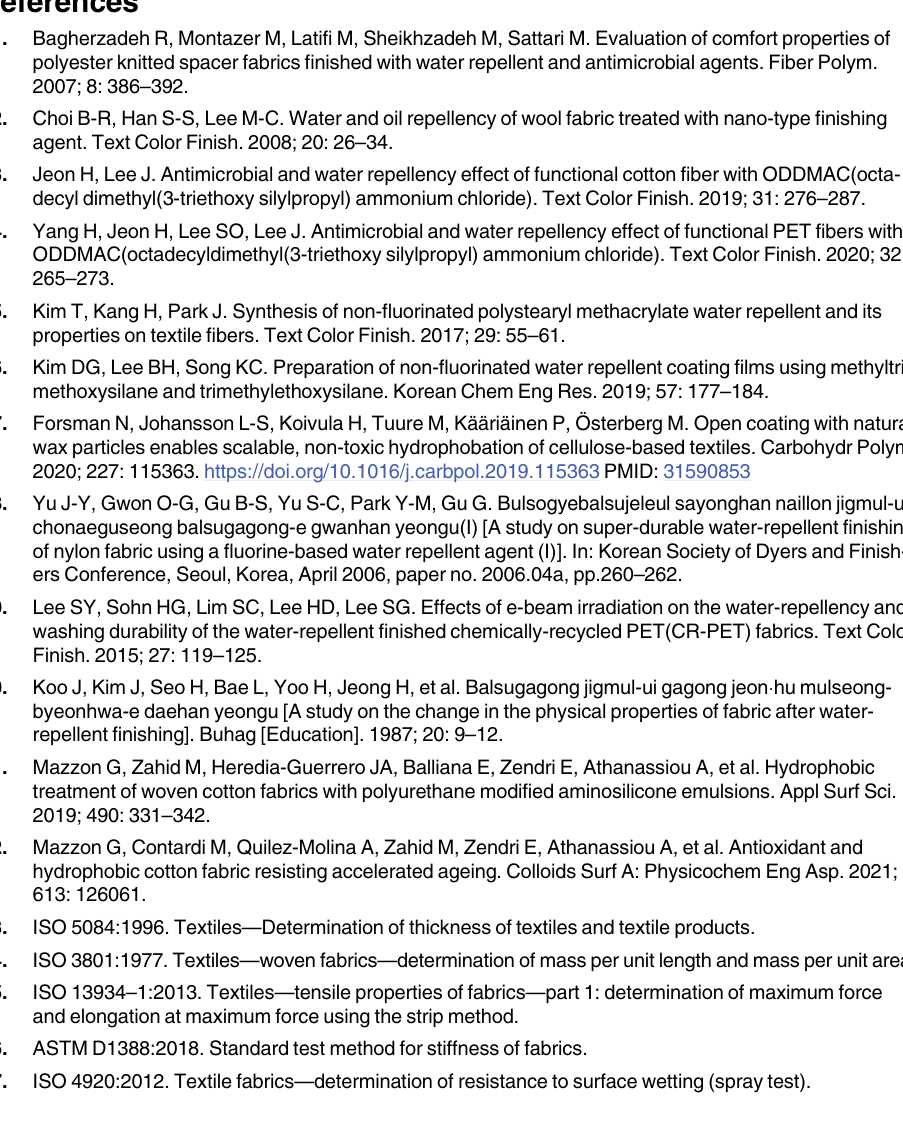
S1 Table. Physical properties of cotton woven fabrics measured five